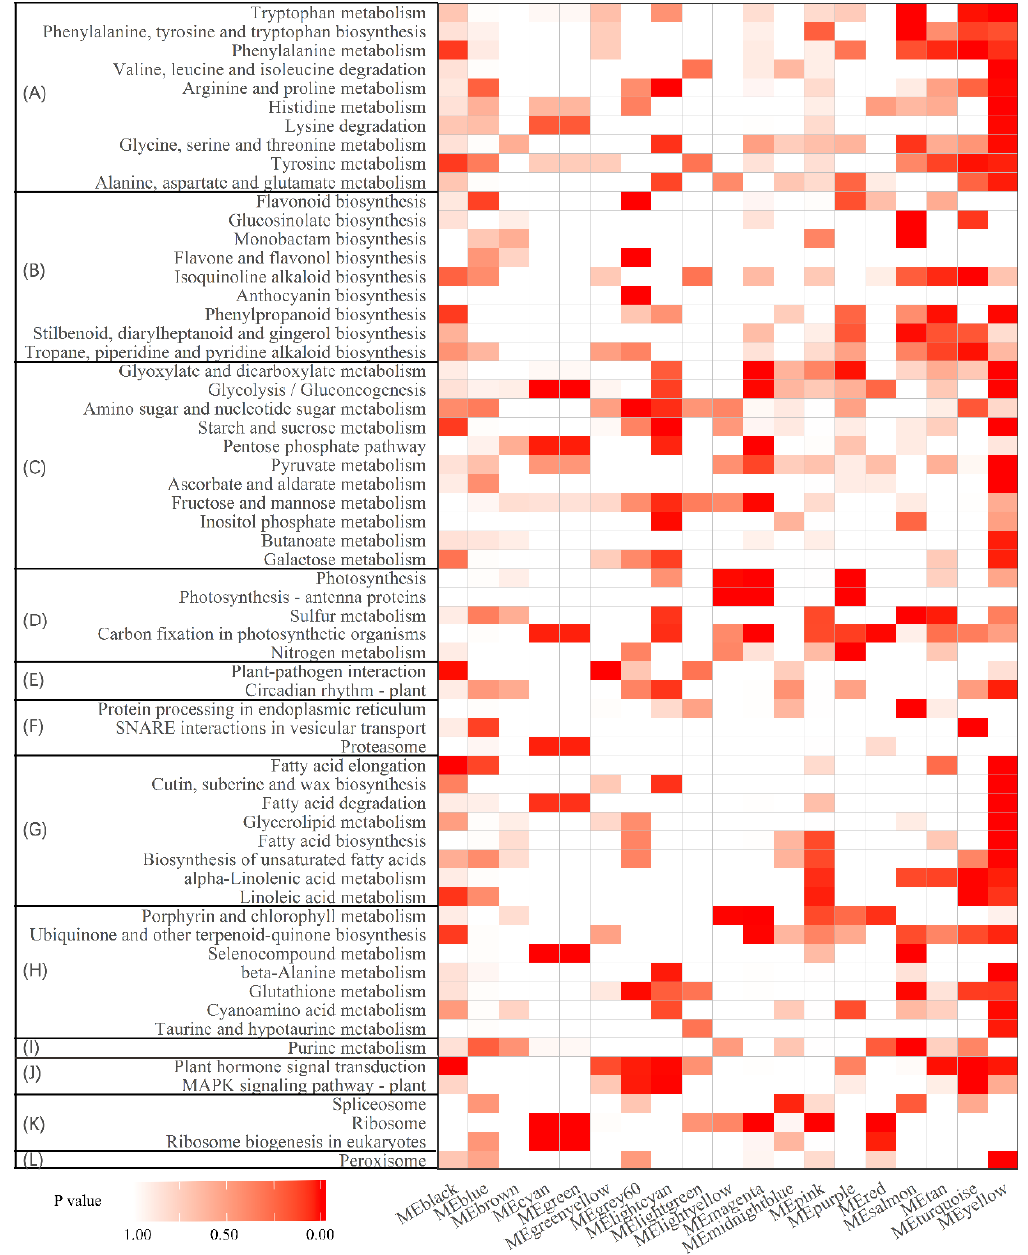
Figure 7. KEGG functional enrichment analysis of genes for each module. ( A ) Amino acid metabo- lism; ( B ) Synthesis of secondary metabolites; ( C ) Carbohydrate metabolism; ( D ) Energy metabolism; ( E ) Environmental adaptation; ( F ) Folding, classification, and degradation metabolism; ( G ) Lipid metabolism; ( H ) Cofactor and vitamin metabolism; ( I ) Nucleotide metabolism; ( J ) Signal transduc- tion; ( K ) Transcription and translation; ( L ) Transport and degradation.